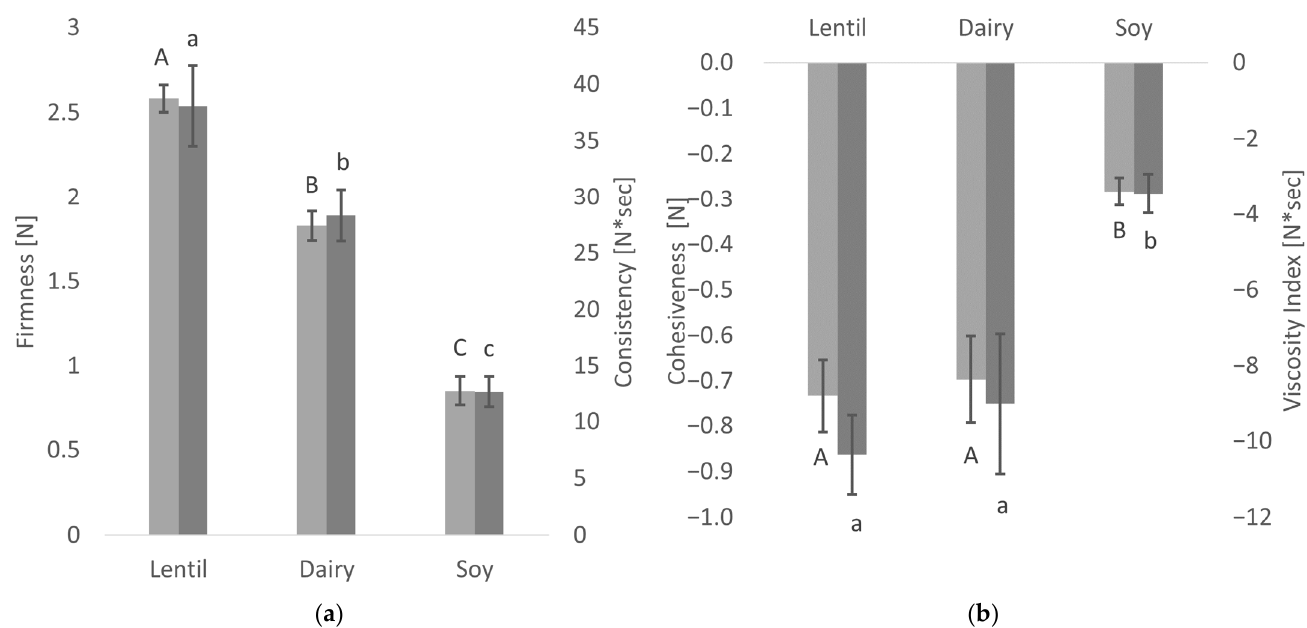
Figure 3. Textural properties of the fermented samples: Means of firmness (light grey) and consistency (dark grey) ( a ) and cohesiveness (light grey) and viscosity (dark grey) ( b ). Values with different superscript letters within columns for firmness and cohesiveness (capital letters) or consistency and viscosity index (lowercase letters) are significantly different ( p ≤ 0.05).